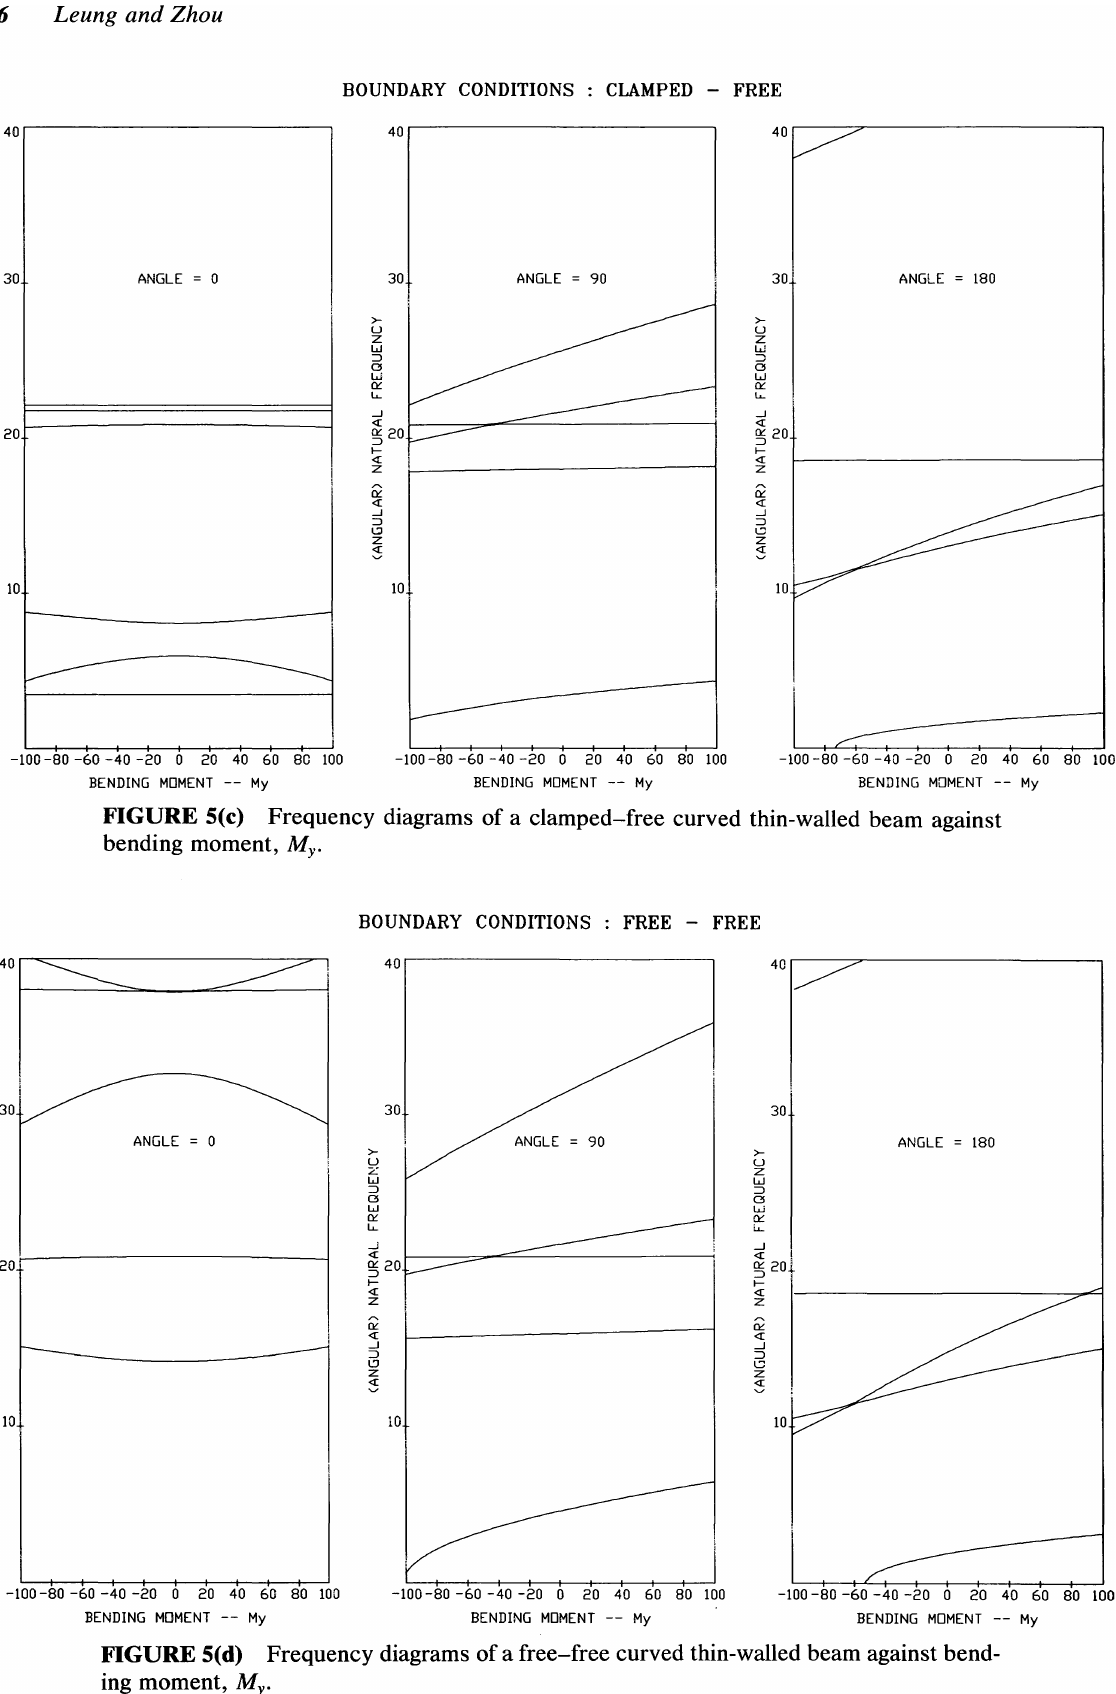
FIGURE 5(d) Frequency diagrams of a free-free curved thin-walled beam against bend ing moment,